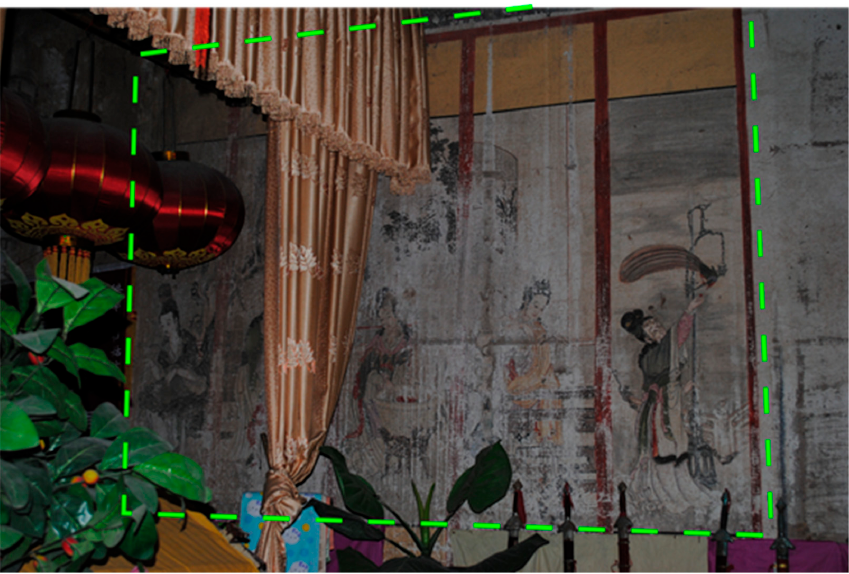
Figure 3. Hanging screen depicting ladys in the Xiangu Temple in Shangdongfeng Village (No. 51 in Figure